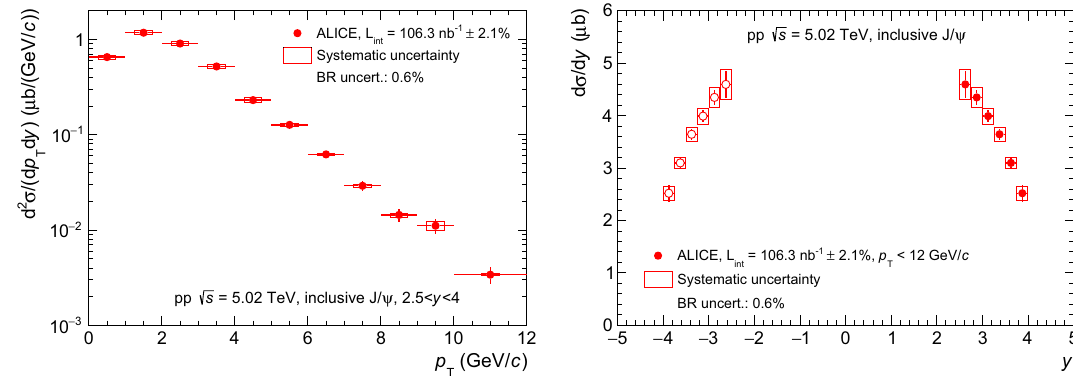
√ s = 5 . 02 TeV. Open symbols are the reflection of the (cid:4) (right) results for Figure 5 shows the (cid:3) p t (cid:4) (left) and (cid:3) p 2 t J /ψ (top) and ψ( 2S ) (bottom). In this figure as well as in Fig. 6, the vertical lines correspond to the quadratic sum of the statistical and uncorrelated systematic